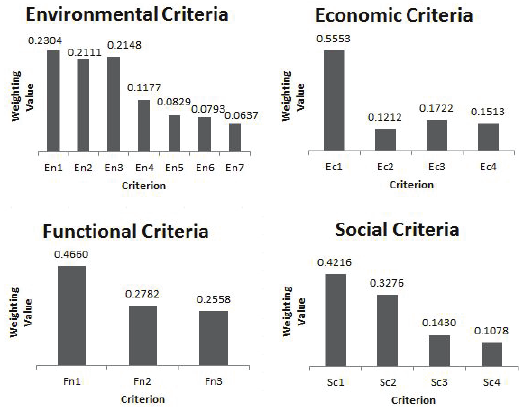
Figure 3. Weighting values of sustainability